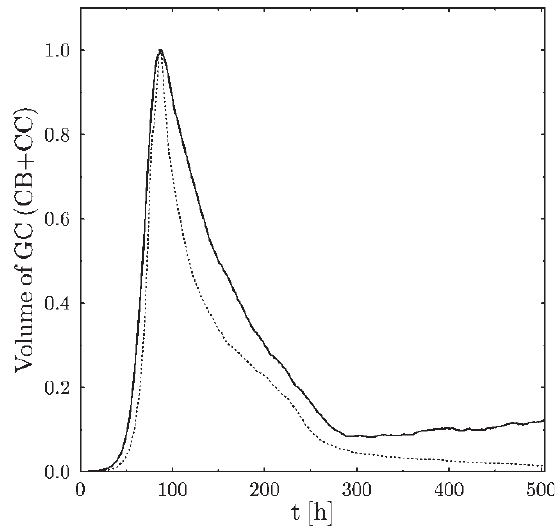
FIGURE 8 Comparing the time course of the GC volume: both time course has been normalized to its maximum value. The cell population kinetics is found to be similar in the signaling (full line) and the chemotaxis model (dotted line). Note the end phase of the GC reaction which seems not to stop in simulations with the signaling model.